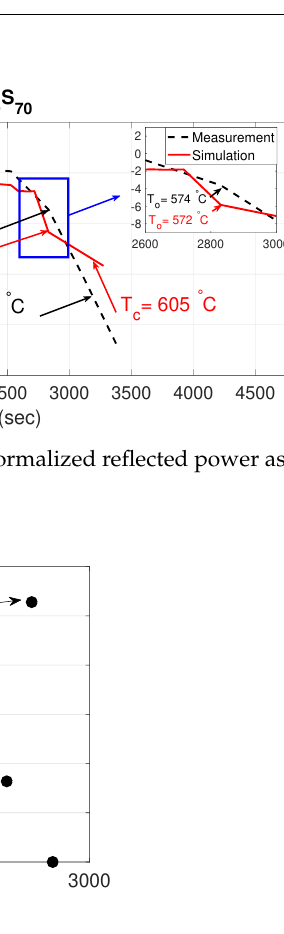
Figure 7. Temperature response of evaporated Ge 40 Se 60 -capped fiber-tip-based temperature